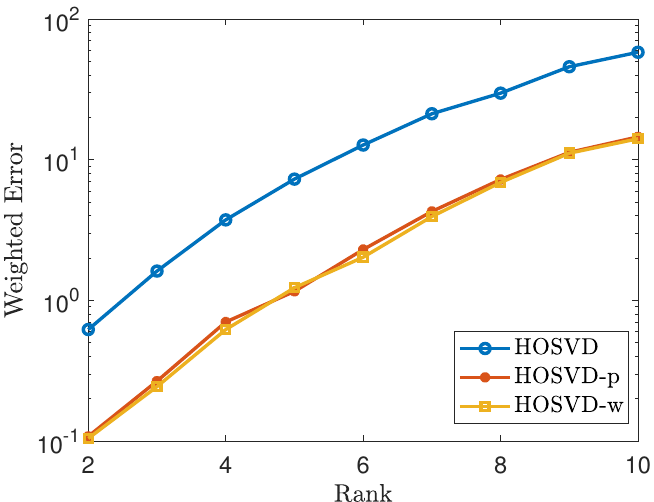
Figure 1. Tensor of size 100 × 100 × 100 using the uniform sampling pattern: plots the errors of the (cid:107)W ( 1/2 ) ( (cid:98) T −T ) (cid:107) F form . The lines labeled as HOSVD, HOSVD-p and HOSVD-w represent the results (cid:26) (cid:107)W ( 1/2 ) (cid:107) F for solving (4), (5) and (6), respectively.